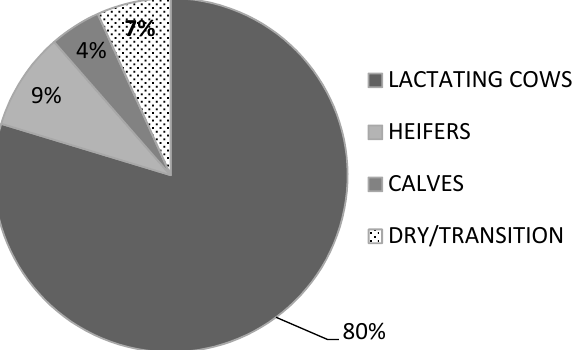
Figure 4. Breakdown of drinking water use (%) by animal category (lactating cows, dry/transition cows, calves and heifers). The dry and transition cow water was modelled based on a period when the dry cows were placed in pasture on a separate water supply.